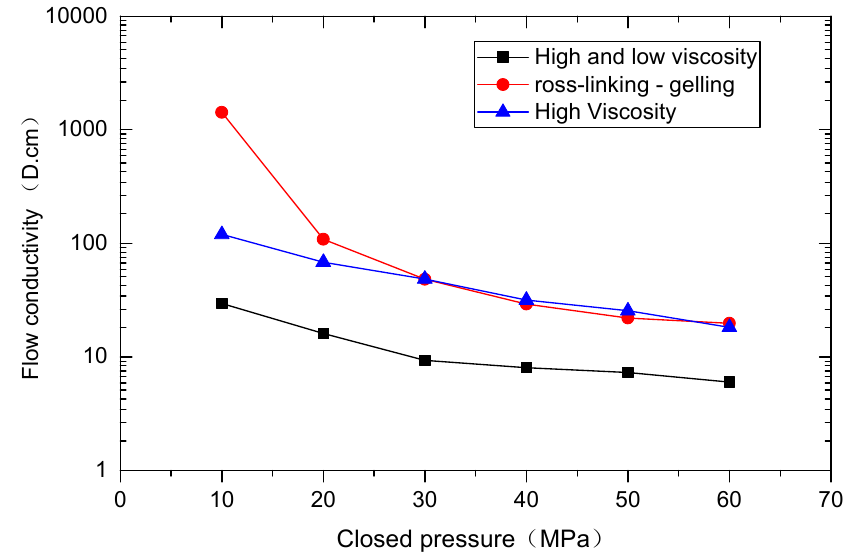
Figure 11. Conductivity of fracture-pore reservoirs under different closing pressures.